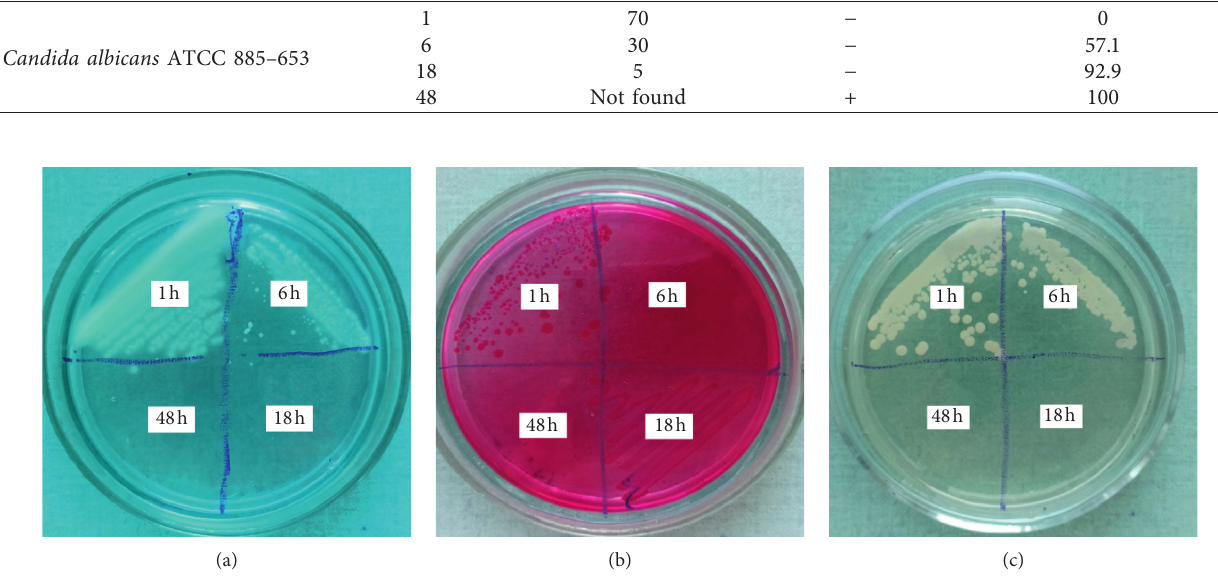
Figure 7: Photos of Petri dishes, illustrating the bactericidal effect of AgNPs solutions, stabilized with rhamnolipid solution, in relation to (a) Staphylococcus aureus ATCC 25923, (b) Escherichia coli ATCC 25922, and (c) Candida albicans ATCC